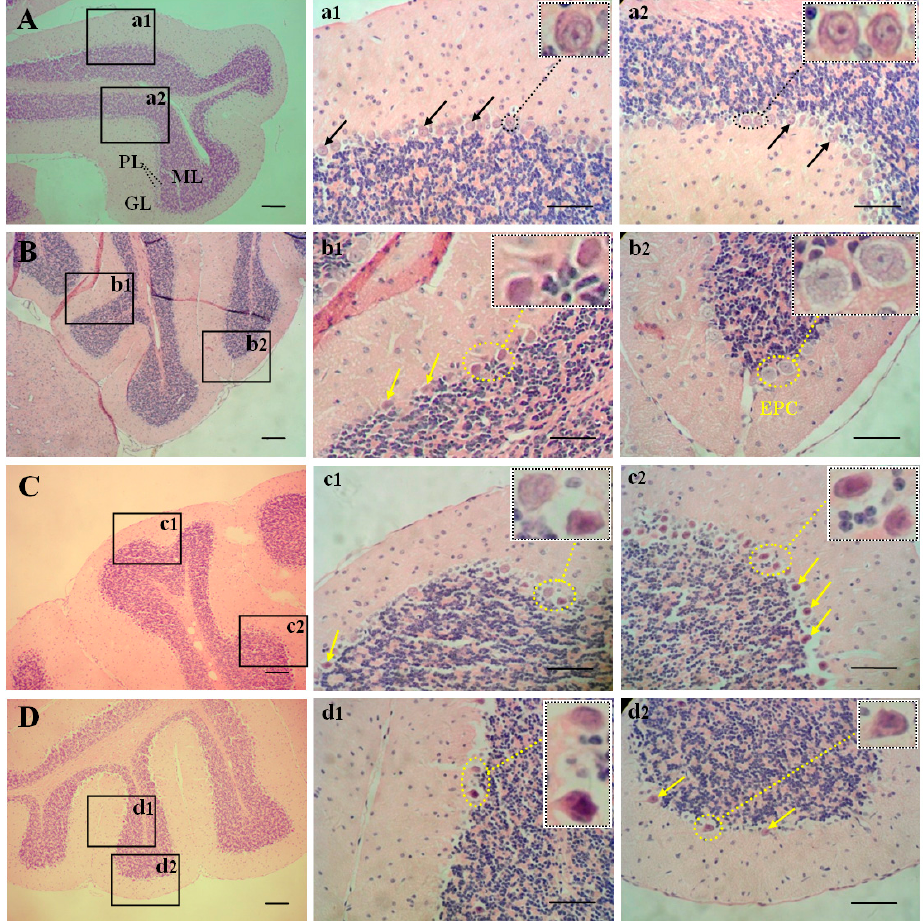
Figure 2. Effect of As exposure on cerebellar morphology of mice. Adult male mice exposed to 0, 1, 2, and 4 mg/L As 2 O 3 in drinking water for 60 days. After treatment, brain sections of mice were stained with hemotoxylin and eosin. Morphology of cerebellum was observed under light microscope. ( A ) a1, a2: control; ( B ) b1, b2: 1 mg/L As 2 O 3 -treated group; ( C ) c1, c2: 2 mg/L As 2 O 3 -treated group; ( D ) d1, d2: 2 mg/L As 2 O 3 -treated group. ML: molecular layer; PL: Purkinje cell layer; GL: granule cell layer; EPC: edematous Purkinje cell. Black arrow: normal Purkinje cell; yellow arrow: shrinked Purkinje cell. Small rectangular pictures surrounded by dotted line in a1-d1, and a2-d2 were the enlarged images of corresponding oval pictures surrounded by dotted lines. Scale bars, 50 µm.